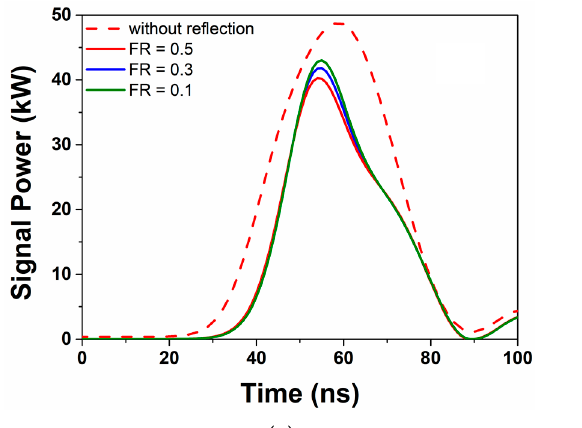
Figure 5. ( a ) The power evolution of the ampli fi ed pulsed signal sequence with and without re fl ec- tion. ( b ) The waveform of the ampli fi ed pulsed with and without re fl ection. The evolutions of the pulse waveform with different FR are analyzed and shown in Figure 6a. During the reduction of FR from 0.1 to 0.5, the peak power of the amplified pulse decreases by 7%, from 42.9 kW to 40.2 kW. The gain attenuation is proportional to the intensity of the reflection feedback. A stronger PW feedback light means a higher number of upper-level population inversions being consumed. The pulse waveforms are normalized and magnified in the time domain for comparison, as shown in Figure 6b. The insertion is the magnified waveform near the pulse peak. The forward PW feedback makes the peak of the pulse appear earlier. The peak of the amplified pulse exceeds what is typical by about 4 ns, and for every 20% increase in FR, the pulse peak moves forward by about 1 ns. The influence of backward reflection on the evolution of the pulse waveform is analyzed in the same way. The backward-reflected feedback has the same effect as the forward-reflected feedback on the gain of the amplifier, as is shown in Figure 7a. Backward reflection has more of an influence on the gain than forward reflection. When the BR is 0.5, the peak power of the pulsed output is 23.4 kW, which is 16.8 kW lower than the peak power at FR = 0.5. This is mainly due to the stronger feedback signal power and the lower residual upper-level population inversion, which has been discussed above. The backward reflection feedback also has an obvious influence on the waveform. The output pulse waveforms for different BR are normalized and compared in Figure 7b. The expanded waveform near the peak is plotted in the insertion. The peak position is delayed by more than 3 ns compared with what is normal. The delay of the pulse peak is positively correlated with the BR feedback intensity.